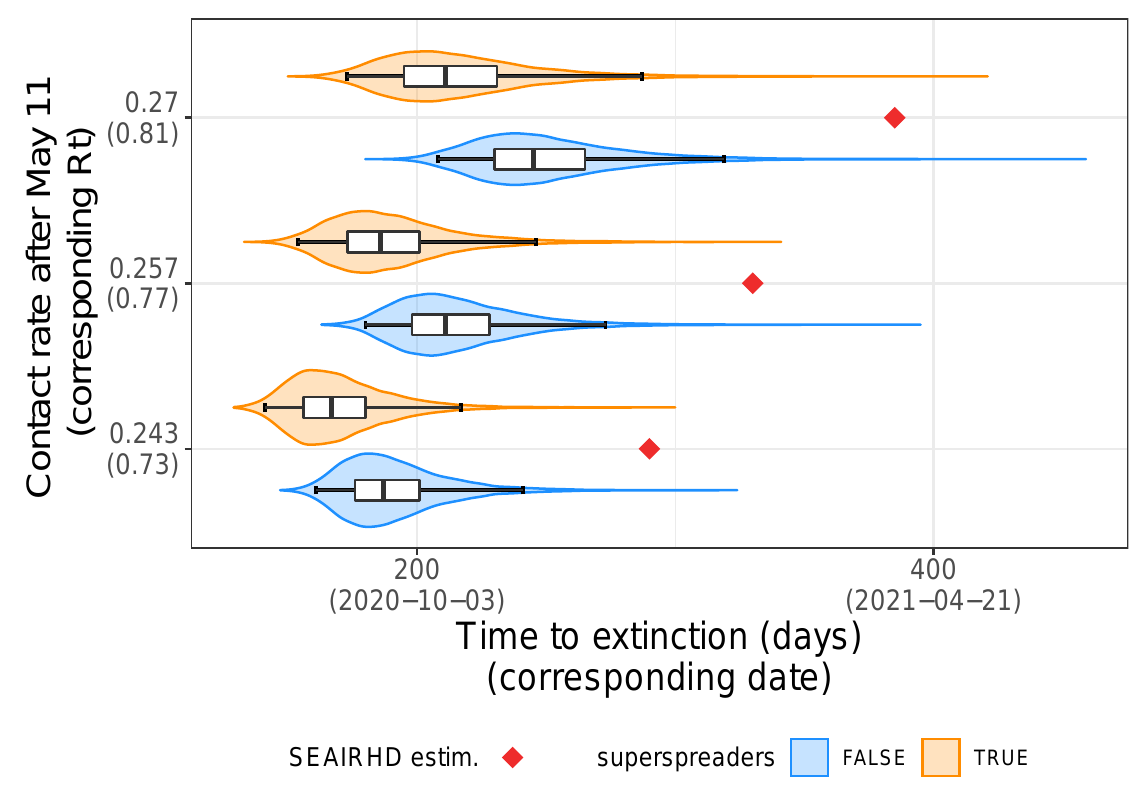
Figure 2 – Effect of lockdown intensity, stochasticity, and superspreading events on the time to extinction ( τ ). The distributions of the time to extinction (in days since the start of the lockdown on March 17) for several lockdown intensities ( η t ) after the first 55 days (i.e. after 11 May 2020) are plotted on the Y-axis using violin plots and boxplots. Results δ R 0 without transmission heterogeneity ( B ) are in orange. In blue, we assume a “ p q Gamma distribution for B . Red diamonds show results from the deterministic Markovian model. The box extends from the lower to upper quartiles of the data. The whiskers expand from the 2.5% to the 97.5%